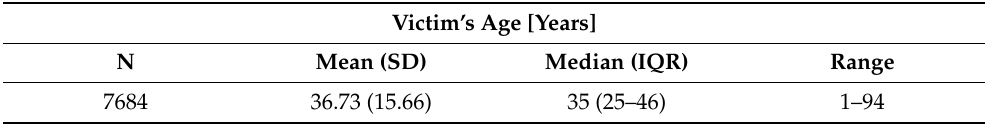
Table 5. Statistical results of the age of victims.